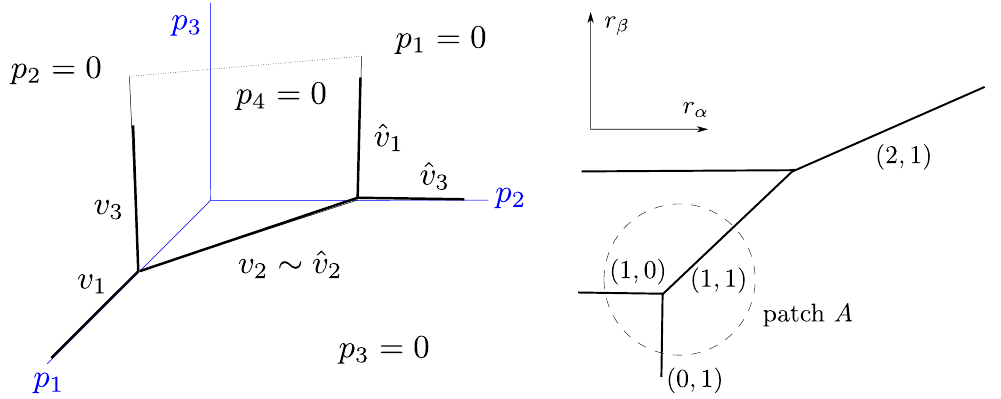
Figure 12 . Left: base of the T 3 (cid:12)bration for O (0) (cid:8) O ( (cid:0) 2) ! P 1 . Right: base for the T 2 (cid:2) R